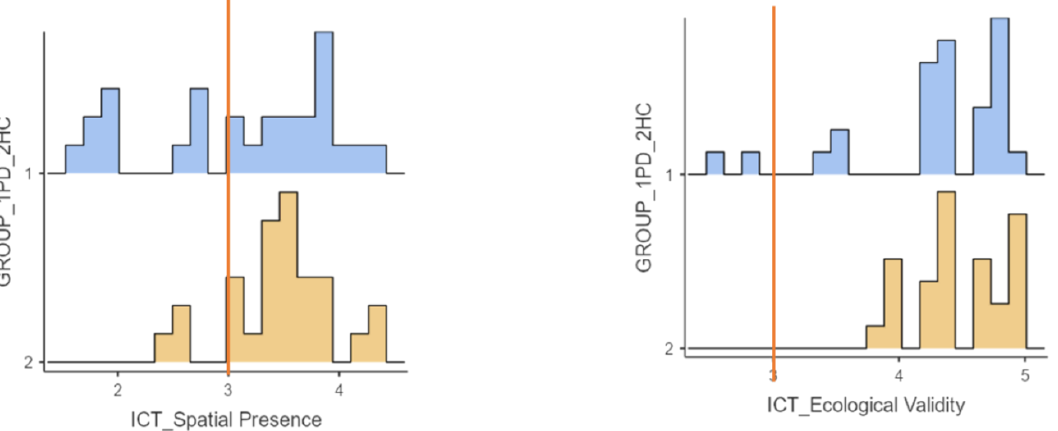
Figure 7. Graphic representation of two ICT—SOPI dimensions. The orange lines indicate a neutral score.